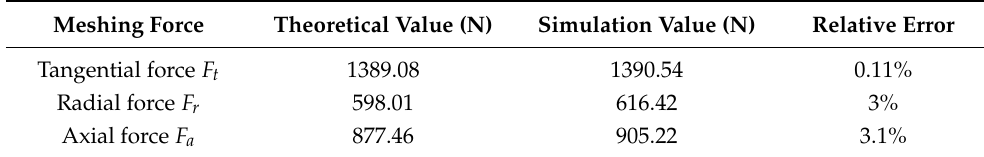
Figure 1. ( a ) Schematic diagram of mine-used linear vibrating screen and virtual prototype model of excitation system. ( b ) Flowchart of the modeling contents. Table 1. Comparison between theoretical value and simulation average value of meshing